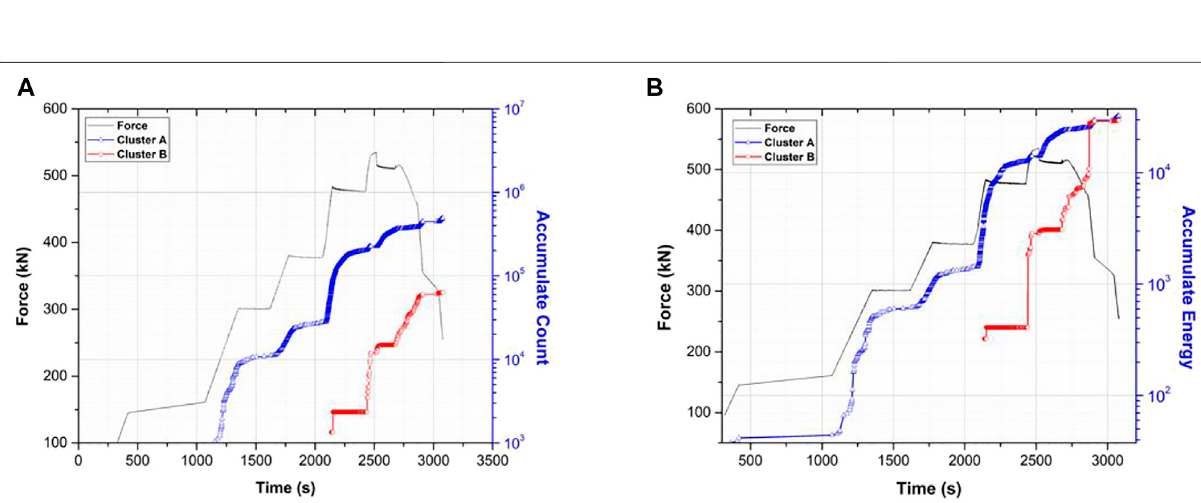
Frontiers in Earth Science |